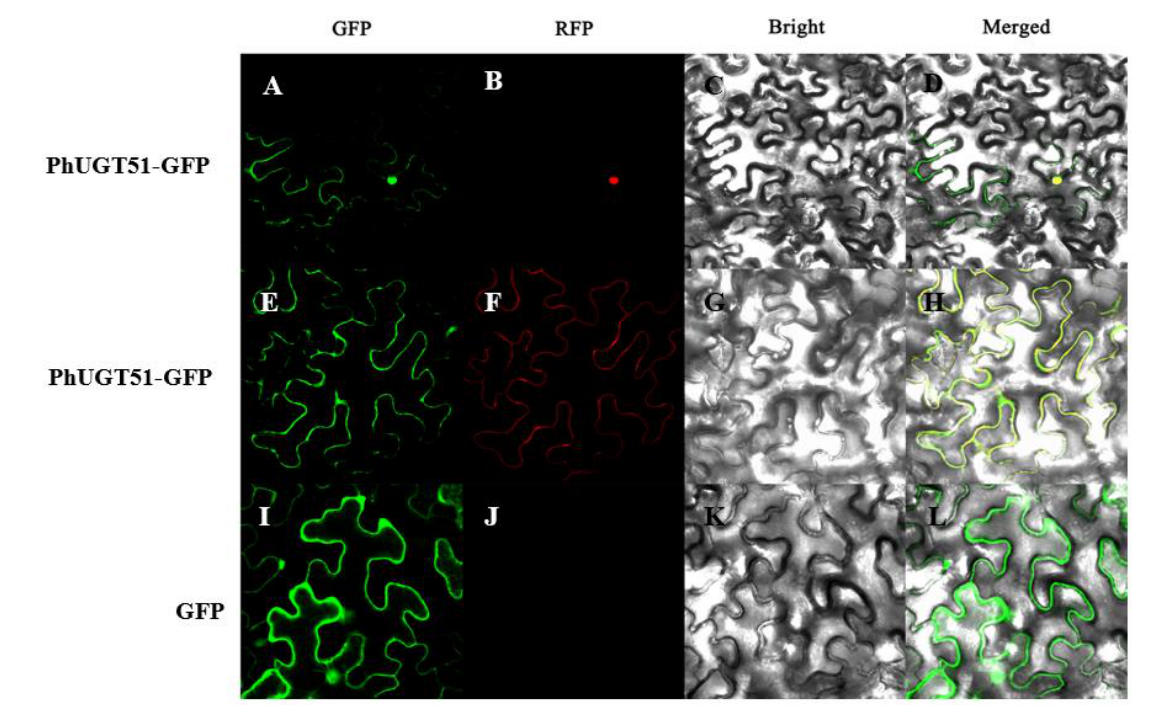
Figure 5. Subcellular localization analysis of PhUGT51. ( A , E , I ) Green fluorescence pictures of PhUGT51-GFP protein and GFP (control). ( B , J ) Red fluorescence pictures of a nucleus marker. ( F ) Red fluorescence picture of a cell membrane marker. ( C , G , K ) Bright field pictures of PhUGT51-GFP protein and control. ( D , H , L ) The combined pictures of PhUGT51-GFP protein and control.